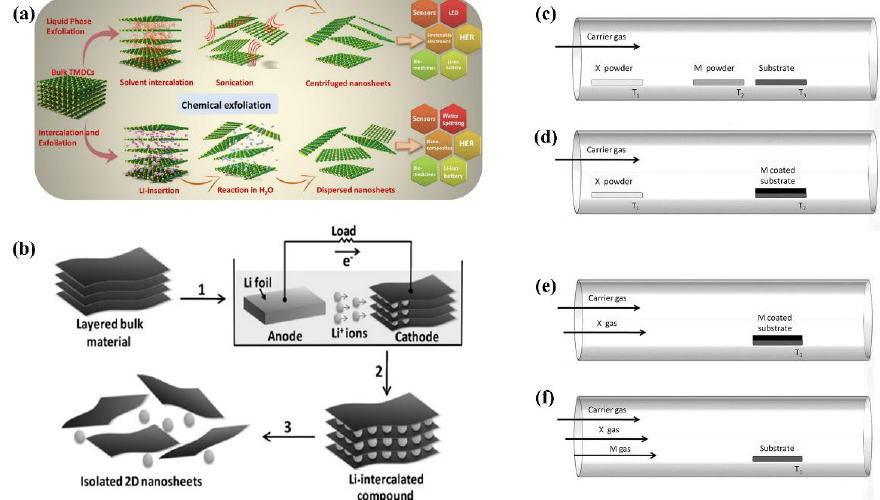
Figure 2. ( a , b ) Different liquid exfoliation mechanisms: ( a ) solvent intercalation, and chemical intercalation [52], and ( b ) electrochemical intercalation [49]; ( c – f ) Chemical vapor deposition setups depending on the precursors [47]. ( a ) Reprinted with permission from Ref. [52]. Copyright 2021, WILEY. ( b ) Reprinted with permission from Ref. [49]. Copyright 2019, RSC. ( c – f ) Reprinted with